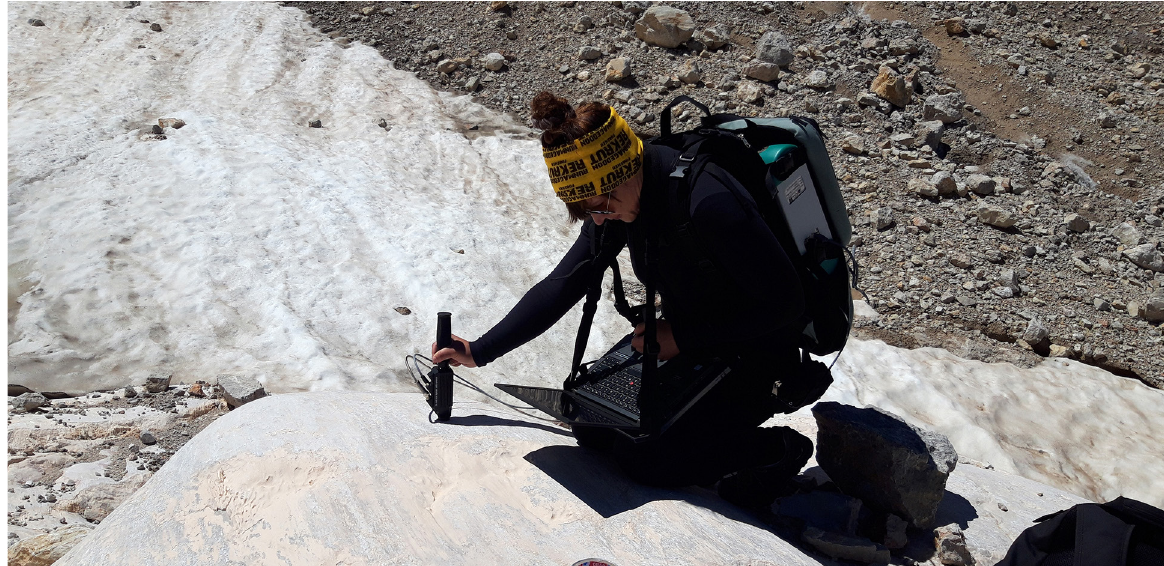
Fig. 3. The spectroradiometer ASD FieldSpec used in weathering studies in front of Hallstätter Glacier in the Alps (photo M.